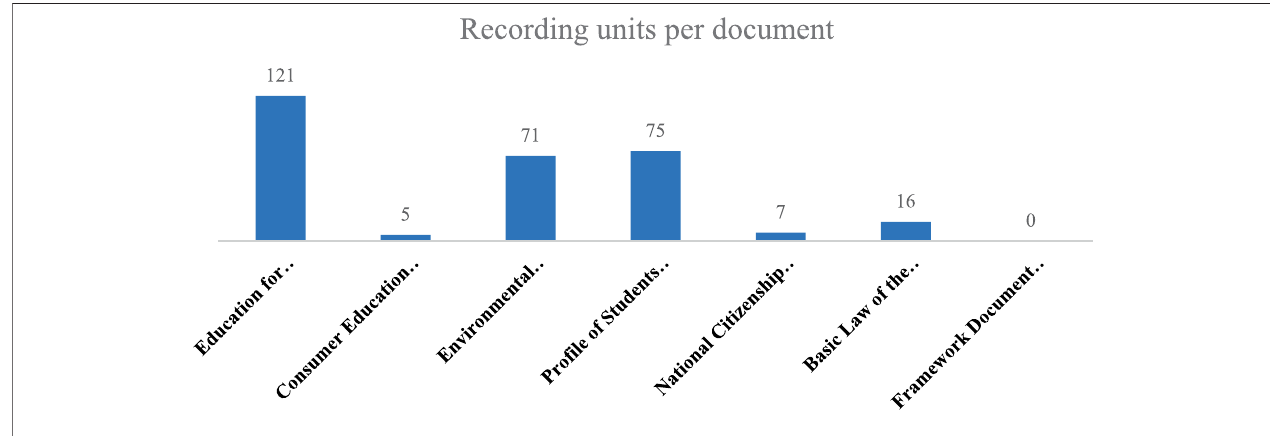
GRAPH 1 | Recording units per